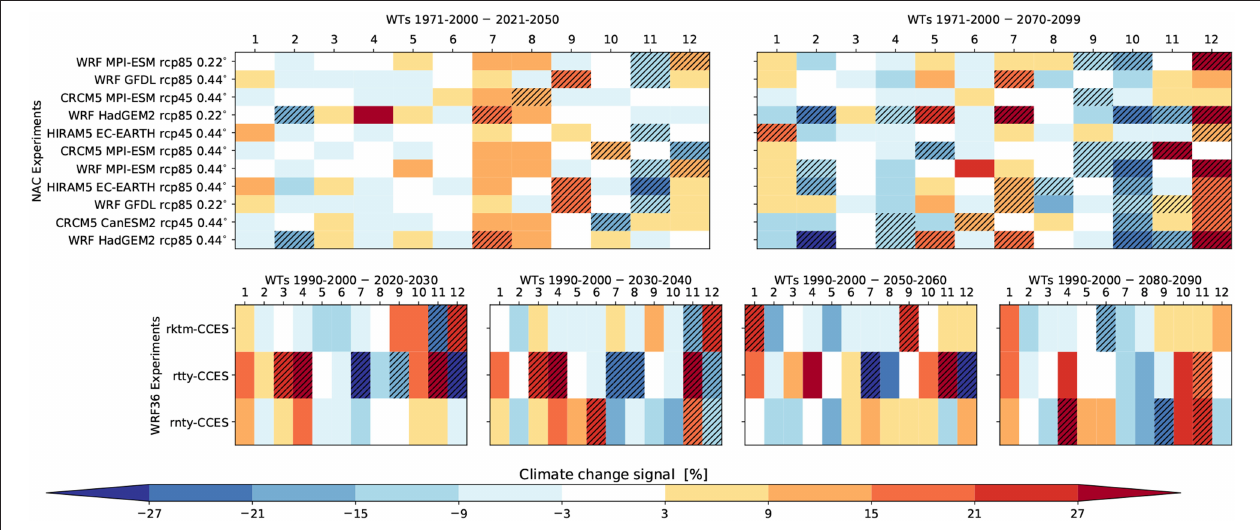
FIGURE 10 | Heatmap showing WT frequency changes in future climate projections. The top panels show results from the NA-CORDEX ensemble using 1979–2000 as the baseline period and 2021–2050 (Left panel) and 2071–2100 (Right panel). The lower panels show results from the WRF36 CESM driven simulations with